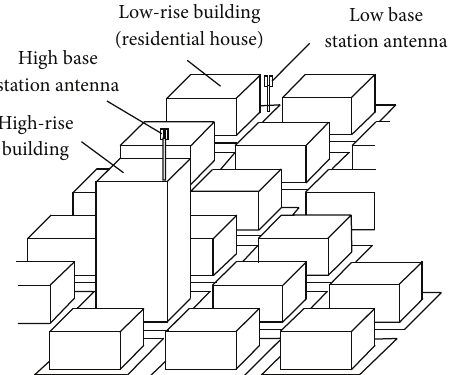
Figure 1: Cochannel interference between high base station and low base station antennas in TDMA/TDD